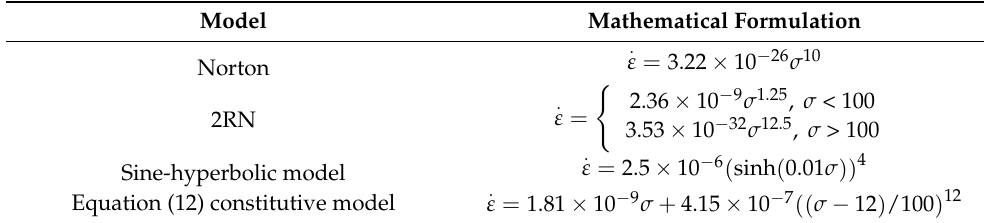
Table 2. Parameters in the constitutive